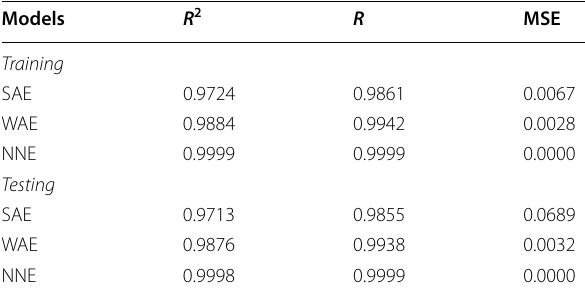
Table 3 Performance of the ensemble techniques